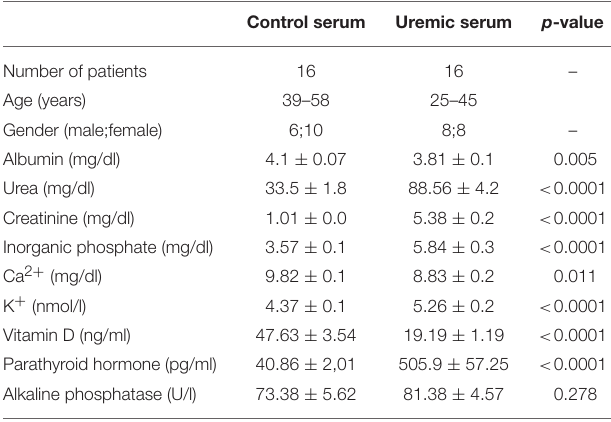
TABLE 1 | Characteristics and biochemical parameters of healthy (control) and uremic serum. Control